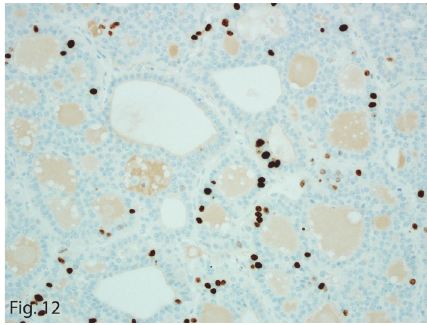
Figure 12: Ki-67 expression in the tumor cells. The mitotic labeling index was 5% (original magnification ×